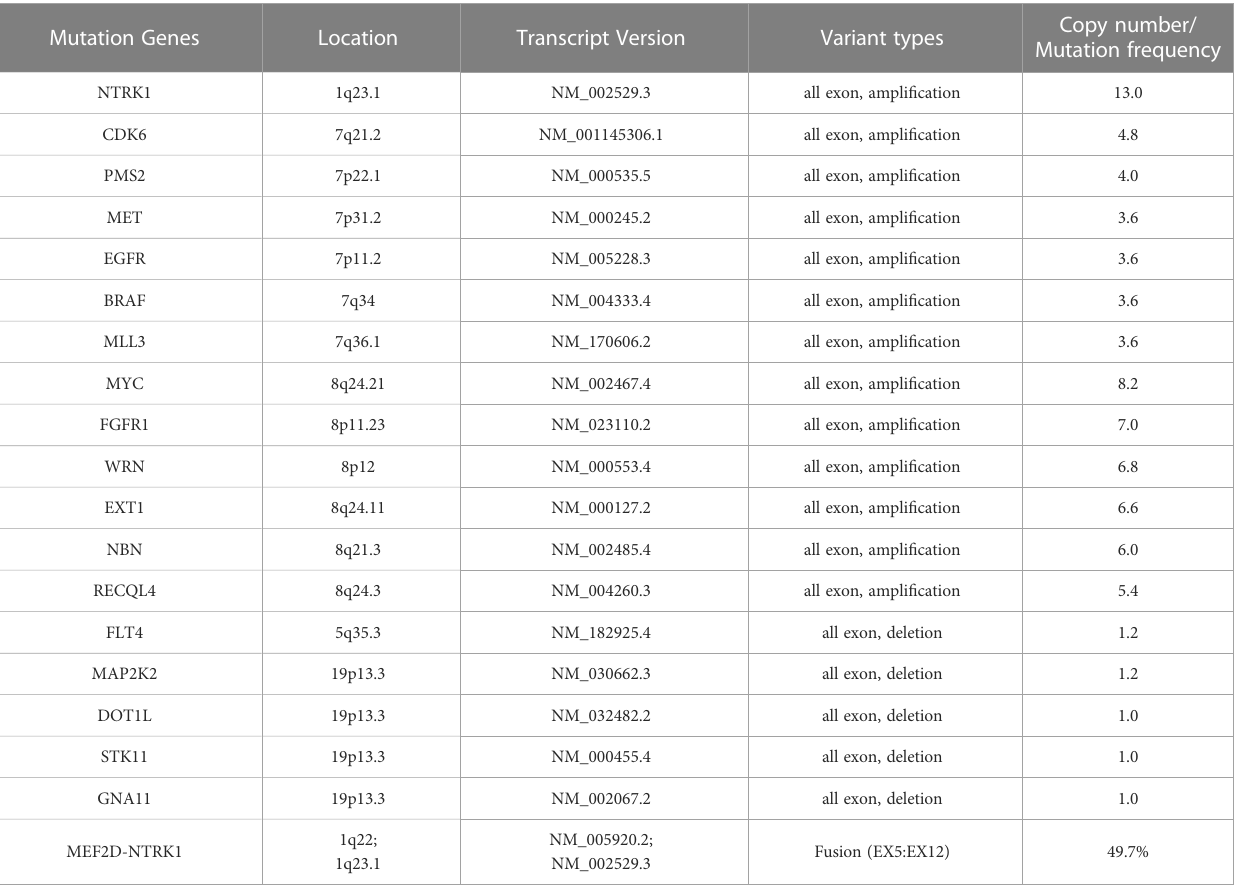
TABLE 1 Genetic mutations of DNA-based next generation sequencing (NGS) in the case. Mutation